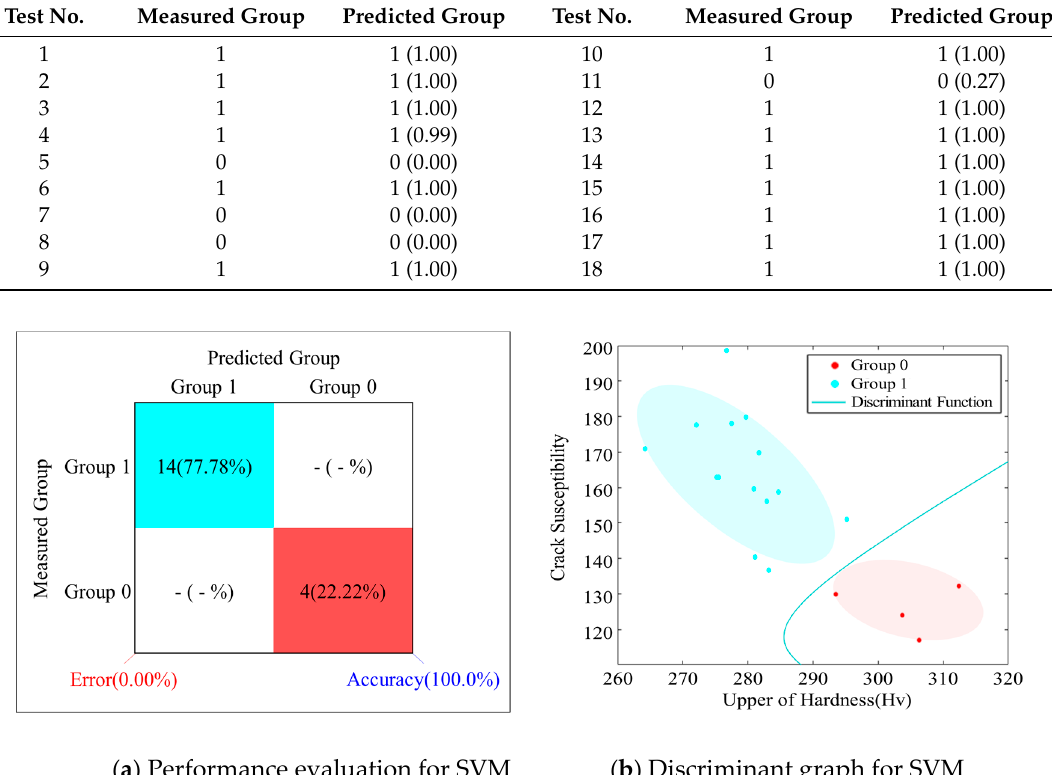
Figure 9. Solidification crack susceptibility discriminant in fiber laser welding: ( a ) Performance evaluation for SVM and ( b ) Discriminant graph for SVM.